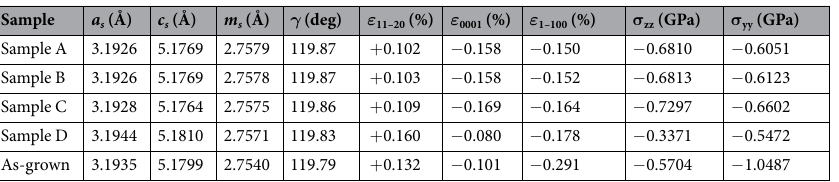
Table 2. Lattice constants, interplanar spacing, distorted angle, strain and stress of all the (11–20) GaN